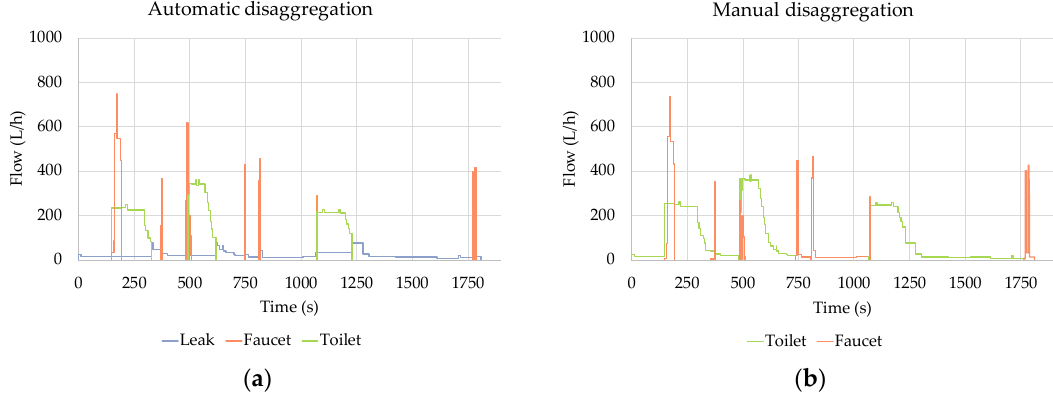
Figure 12. Manual vs automatic disaggregation (example from the household HH ‐ 06 of R1).